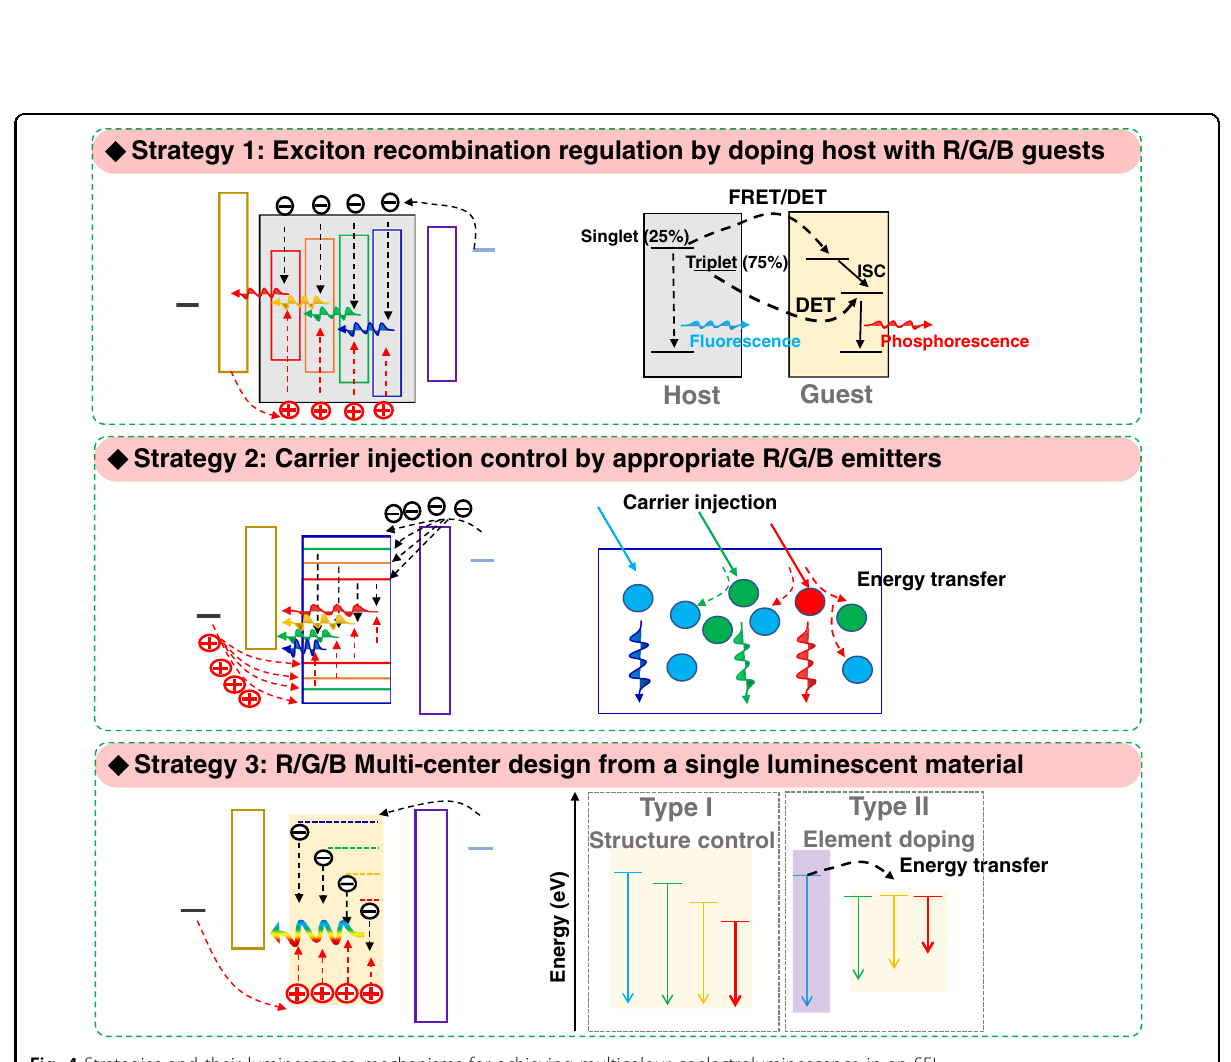
Fig. 4 Strategies and their luminescence mechanisms for achieving multicolour coelectroluminescence in an